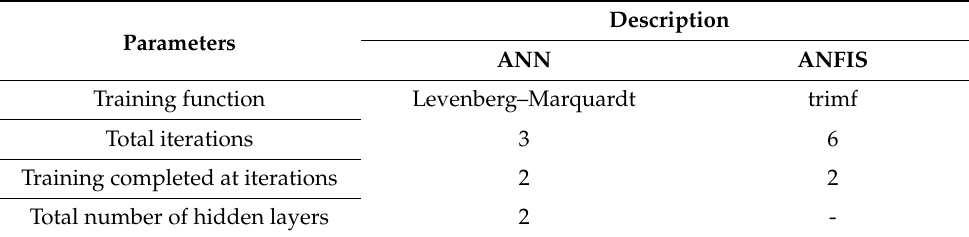
Table 3. Parametric adjustments for ANN and